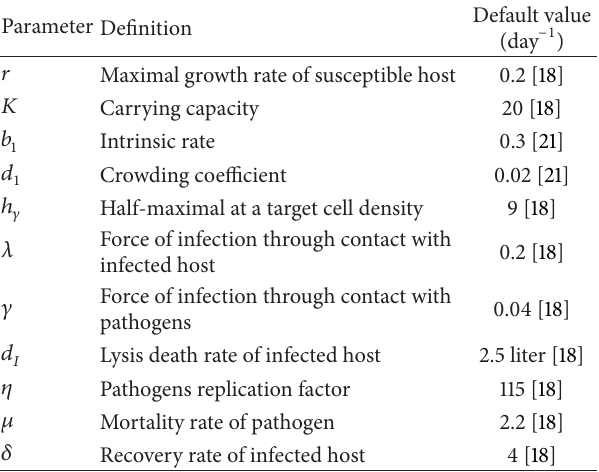
Table 3: Values of parameters used in model